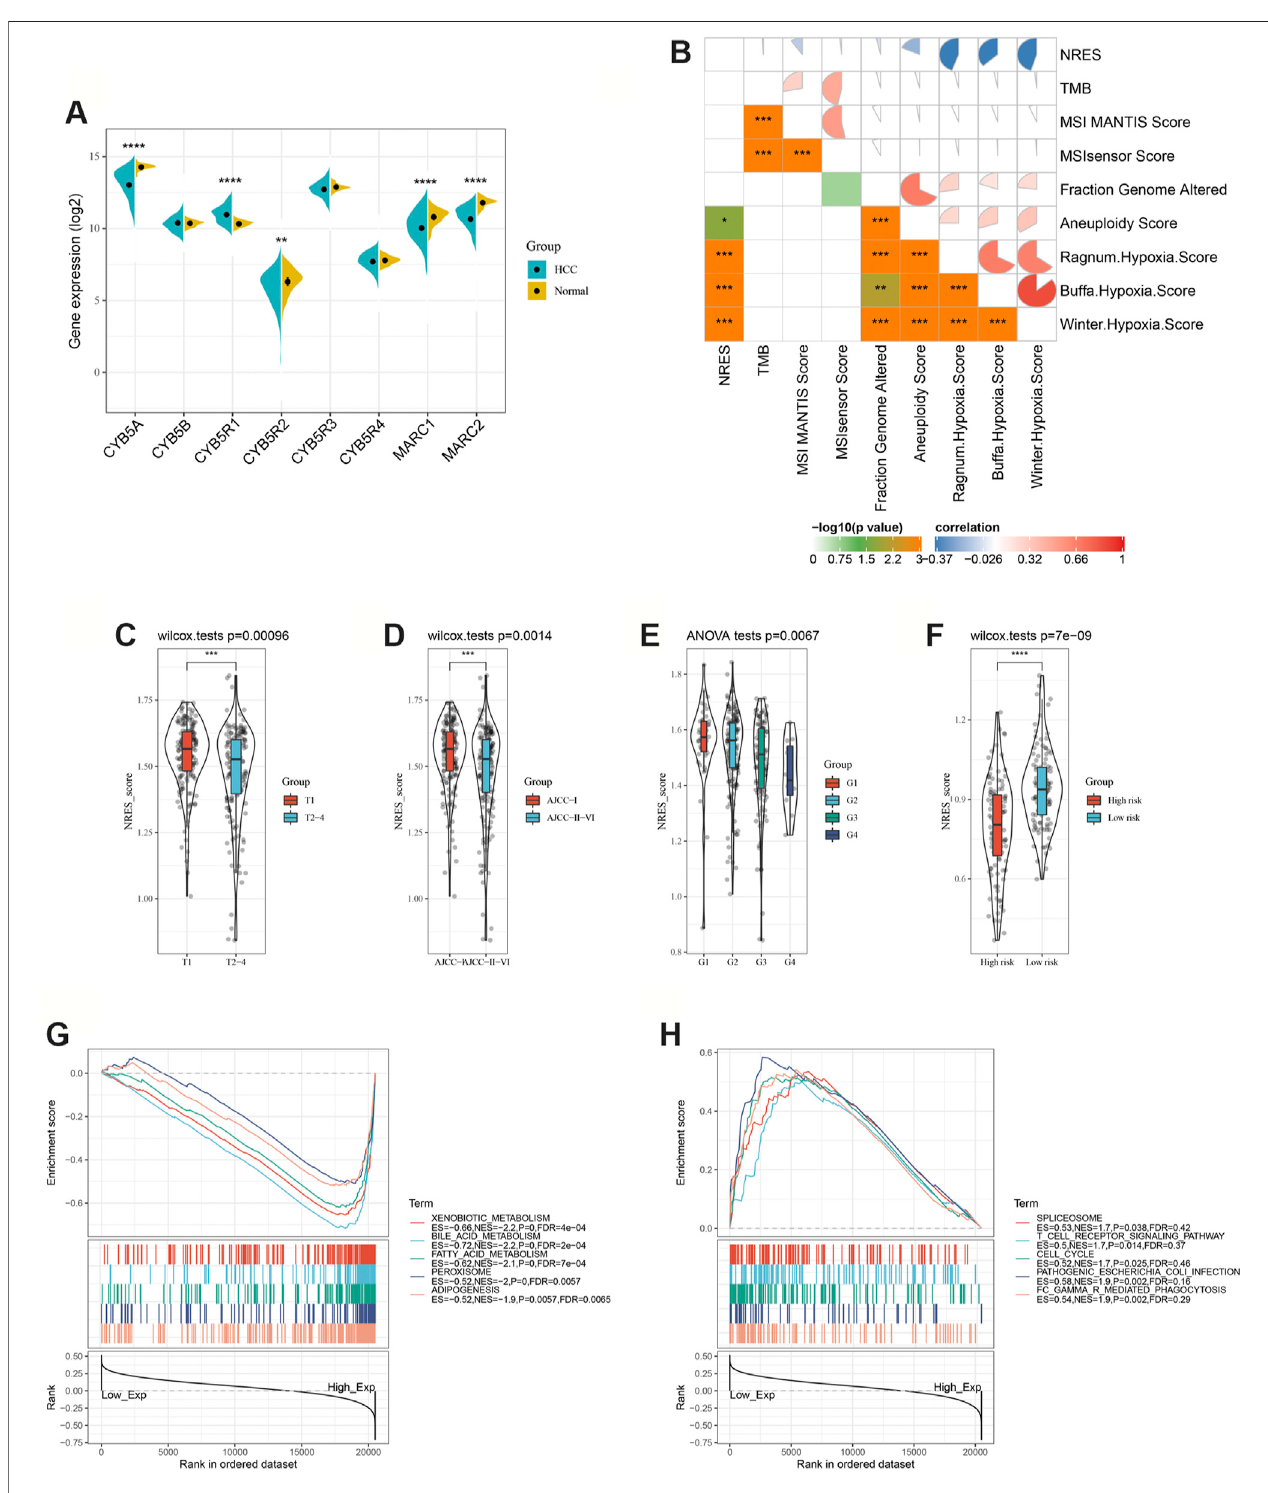
FIGURE 1 | NRES expression was associated with HCC progression. (A) Compared the gene expressions of NRES components between normal and HCC tissues. (B) The correlation between NRES and different clinical scores. (C – F) Compared the gene expressions of NRES components between different groups. Tumor size (T), AJCC stage and tumor pathology grade (G) were obtained from TCGA-LIHC datasets; metastasis risk for HCC was obtained from GEO14520 datasets. (G – H) Signaling pathways signi fi cantly correlated with NRES. Data was generated by GSEA. The Pearson correlation coef fi cient was used to determine the correlation. *p < 0.05; **p < 0.01; ***p < 0.001.